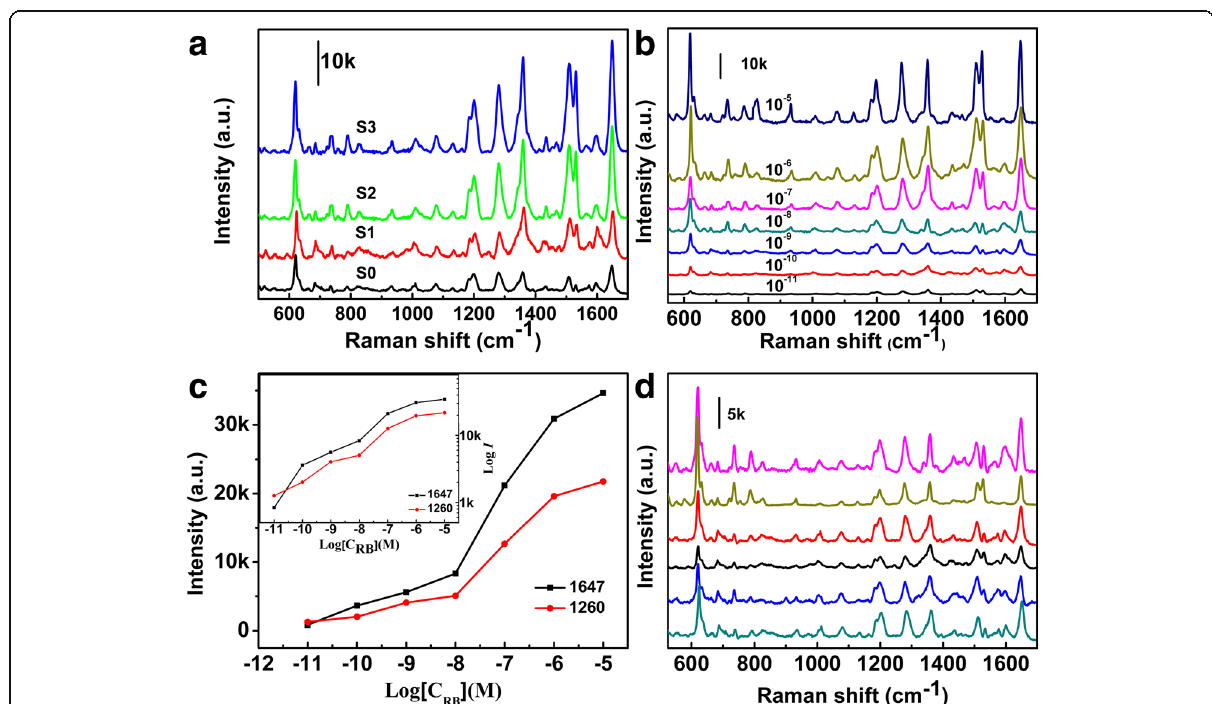
Fig. 6 a SERS spectrum of RB with different substrates. RB (10 − 7 M). b SERS spectrum of RB with a gradient concentration. c The relationship between the Raman intensity and logarithmic RB concentrations for the bands at 1647 and 1260 cm − 1 . Log-log plot of the Raman intensity versus the concentration of RB is shown in the inset. d Six SERS spectra collected randomly in the scanned area on the substrate. RB (10 − 9